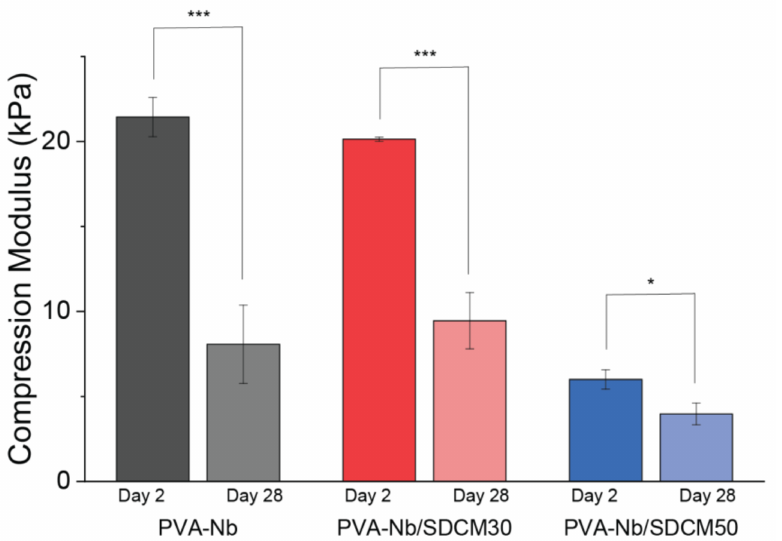
Figure 5. Compression modulus of PVA-Nb hydrogels (10 % wt/vol) cross-linked with 0.5 equiva- lent DT and 2 mM LAP. PVA-Nb, PVA-Nb/SDCM30, and PVA-Nb/SDCM50 after 2- and 28-days’ incubation in PBS. * p < 0.5, *** p <